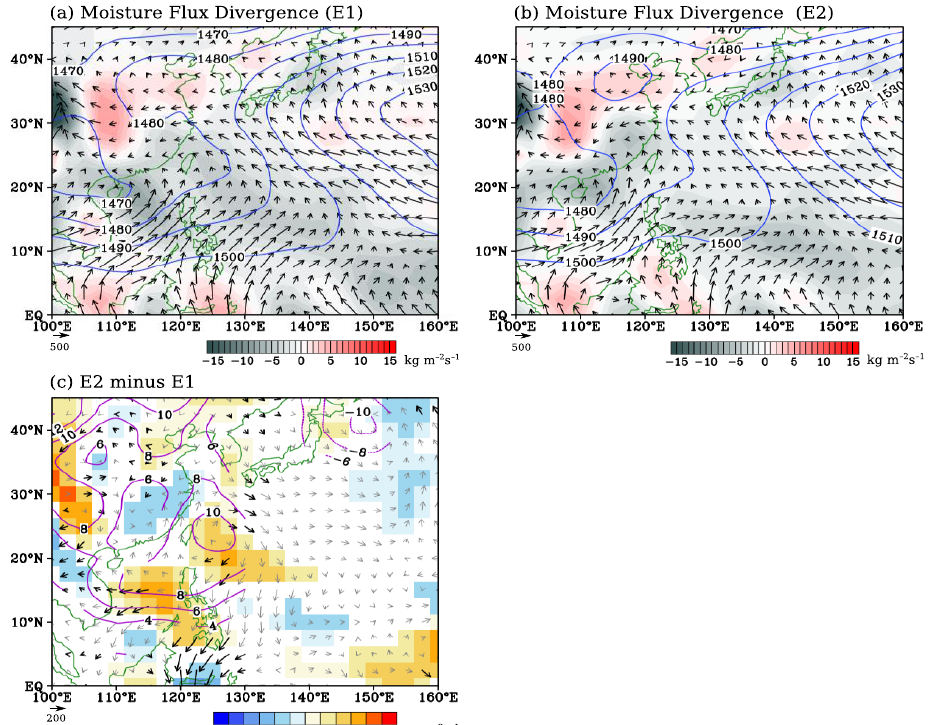
Figure 7. Smoothed (1–2–1 filter) vertically integrated moisture flux (vectors; kg m − 1 s − 1 ), moisture flux divergence (kg m − 2 s − 1 ; shading), and 850-hPa geopotential height (contours; m) for P45–P50 during: ( a ) E1 (1979–1993); ( b ) E2 (1994–2008); and their ( c ) epochal difference (E2 minus E1). ( a – c ) The contour interval is 10 m. Shaded areas, black arrows, and purple contours in ( c ) indicate statistical significance above the 90% confidence level. The scale of the vectors is indicated on the lower-left corner of each figure.